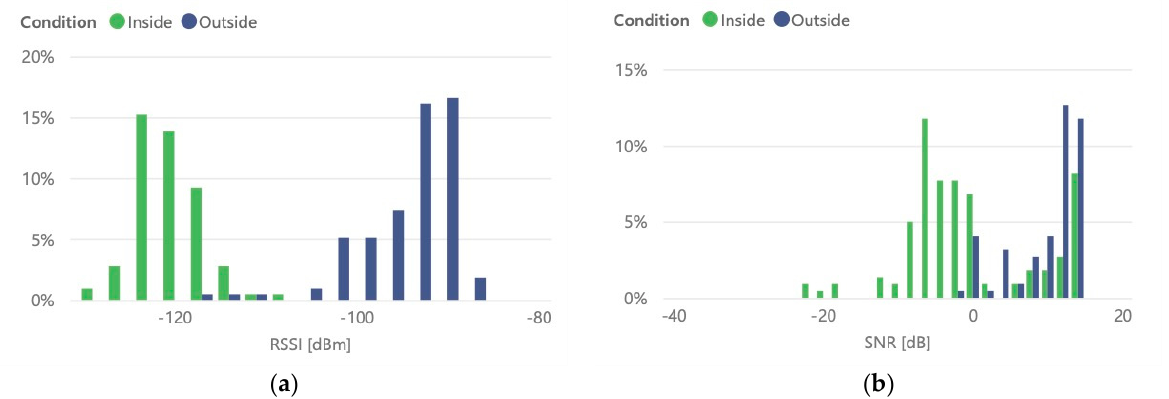
Figure 18. Underground container received messages: ( a ) radio quality RSSI; ( b ) SNR measurements.